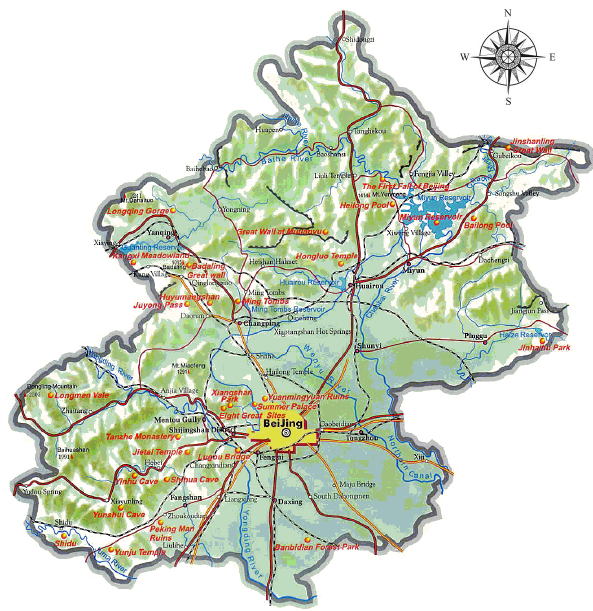
Fig.1. Topographic map of Beijing Fig. 1. Topographic map of Beijing.